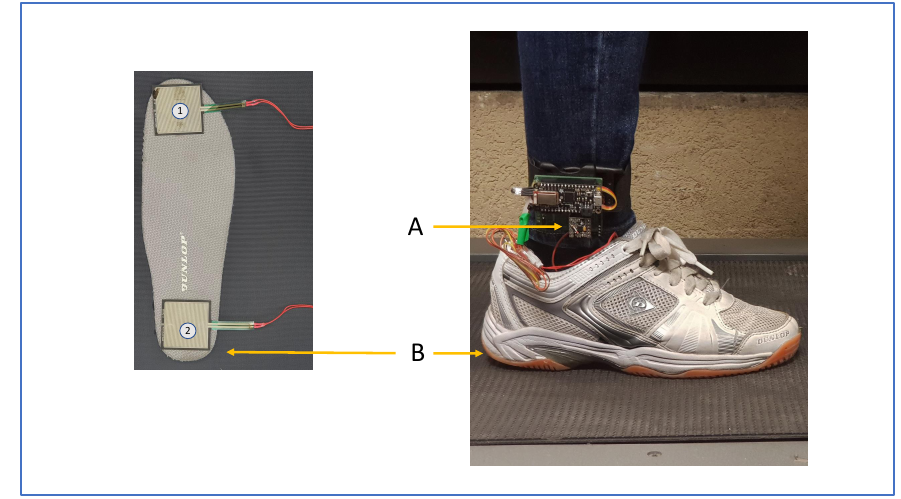
Figure 5. Sensor positions of the IMU and the FSR on the foot. Arrow (A) illustrates the position of the IMU, and arrow (B) the position of FSRs under the